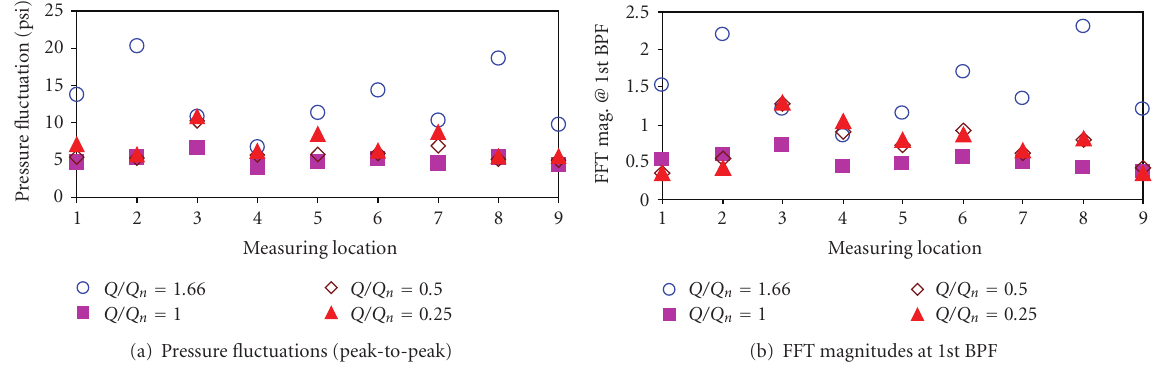
Figure 7: E ff ect of flow rate and measuring location on pressure fluctuations: impeller-I.